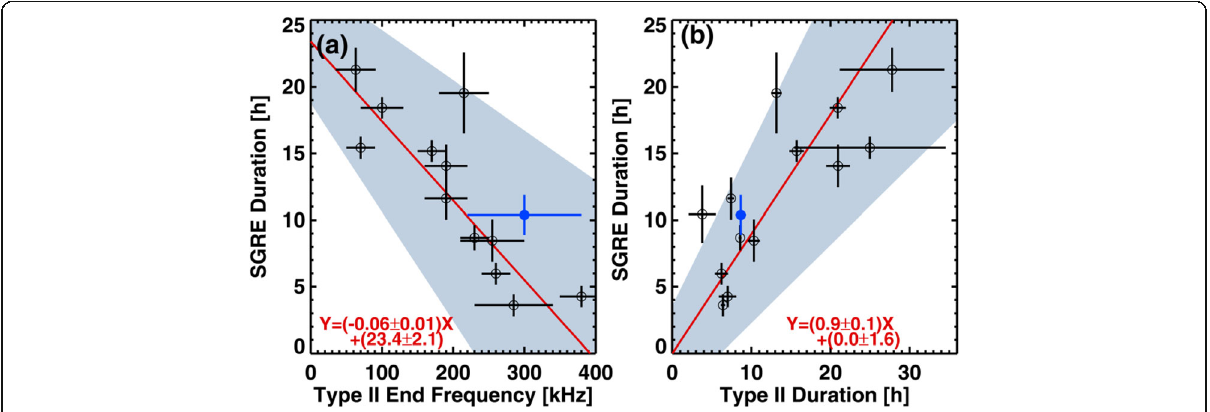
Fig. 21 Scatter plots of SGRE duration with type II ending frequency ( a ) and type II duration ( b ). The best-fit lines (red) are obtained using the Orthogonal Distance Regression method, which considers errors in both X and Y variables. The shaded area represents 95% confidence interval of the fit (after Gopalswamy et al.